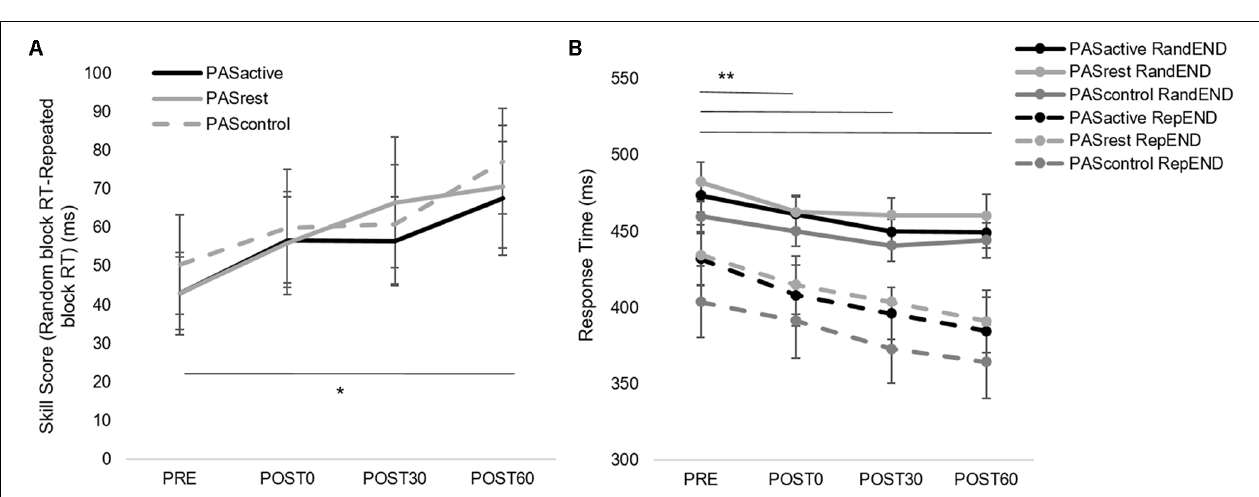
Frontiers in Human Neuroscience | www.frontiersin.org